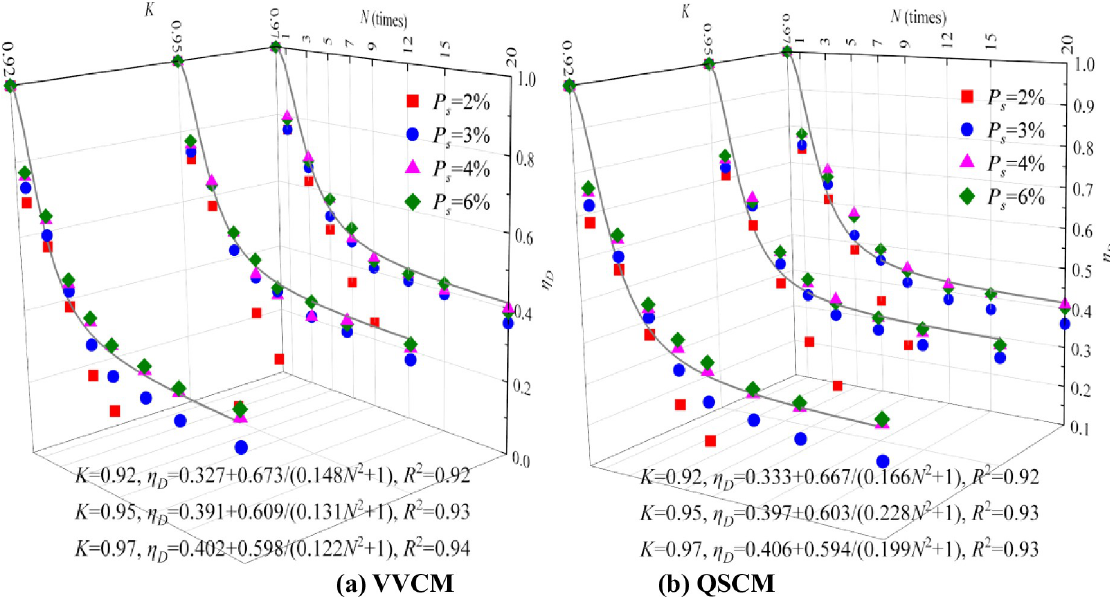
Fig 3. Strength degradation equation of CIL with different K after freeze–thaw